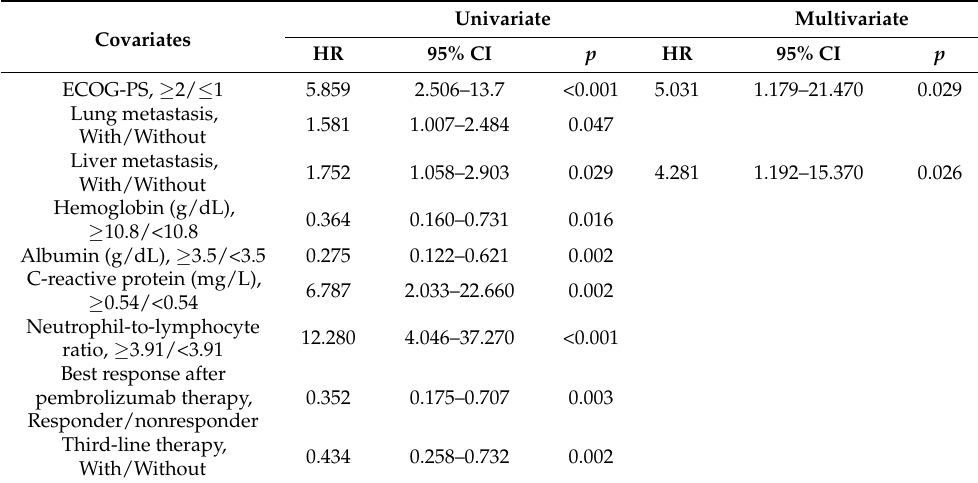
Table 3. Univariate and multivariate Cox proportional hazard regression analysis according to over- all survival.